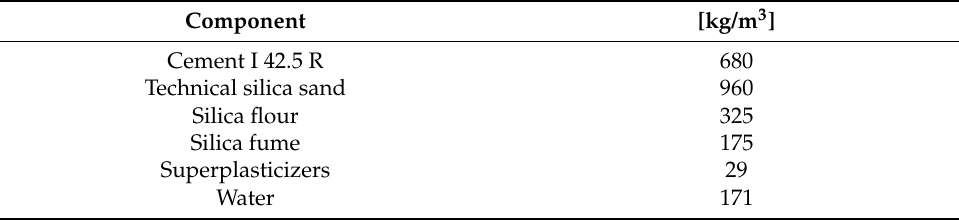
Table 1. High-performance concrete mix